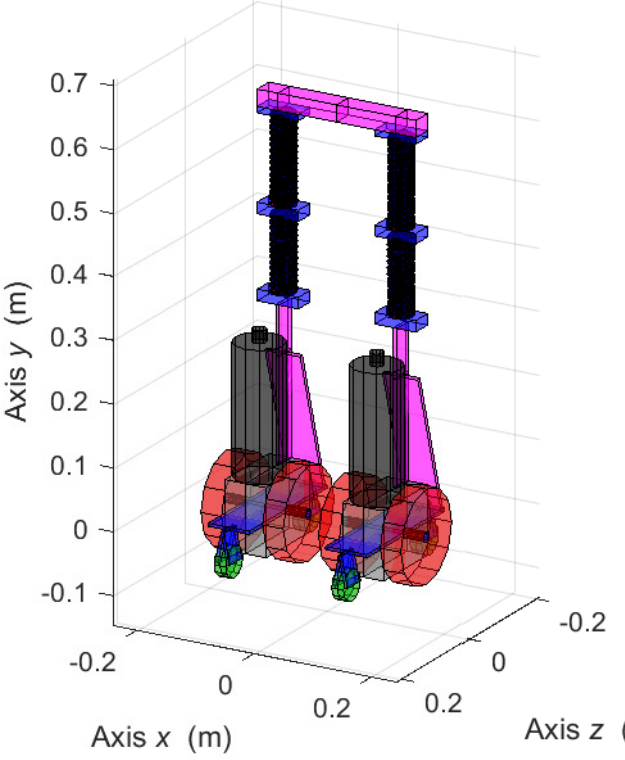
Figure 2. Model of Rollo in Lupos